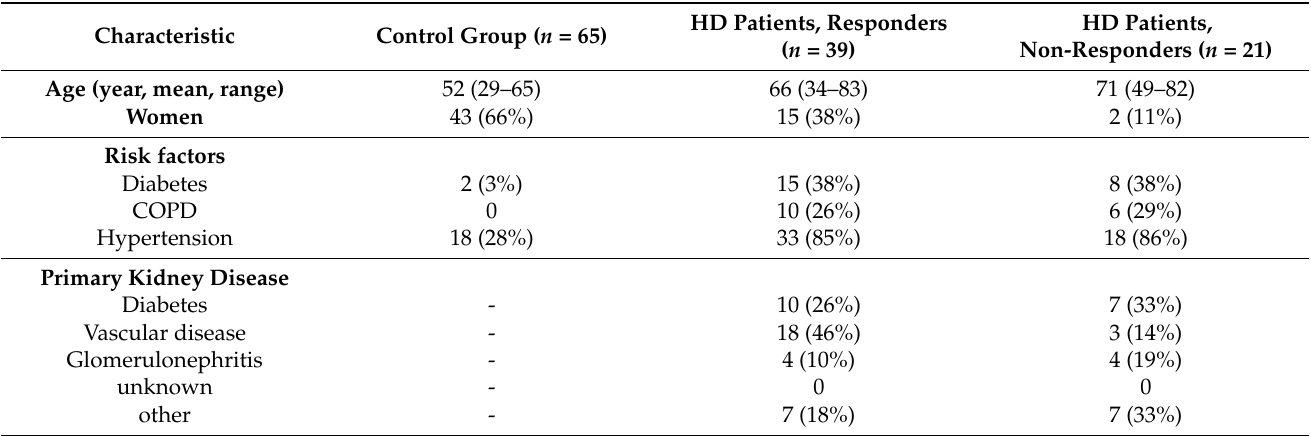
Table 1. Demographics of the study